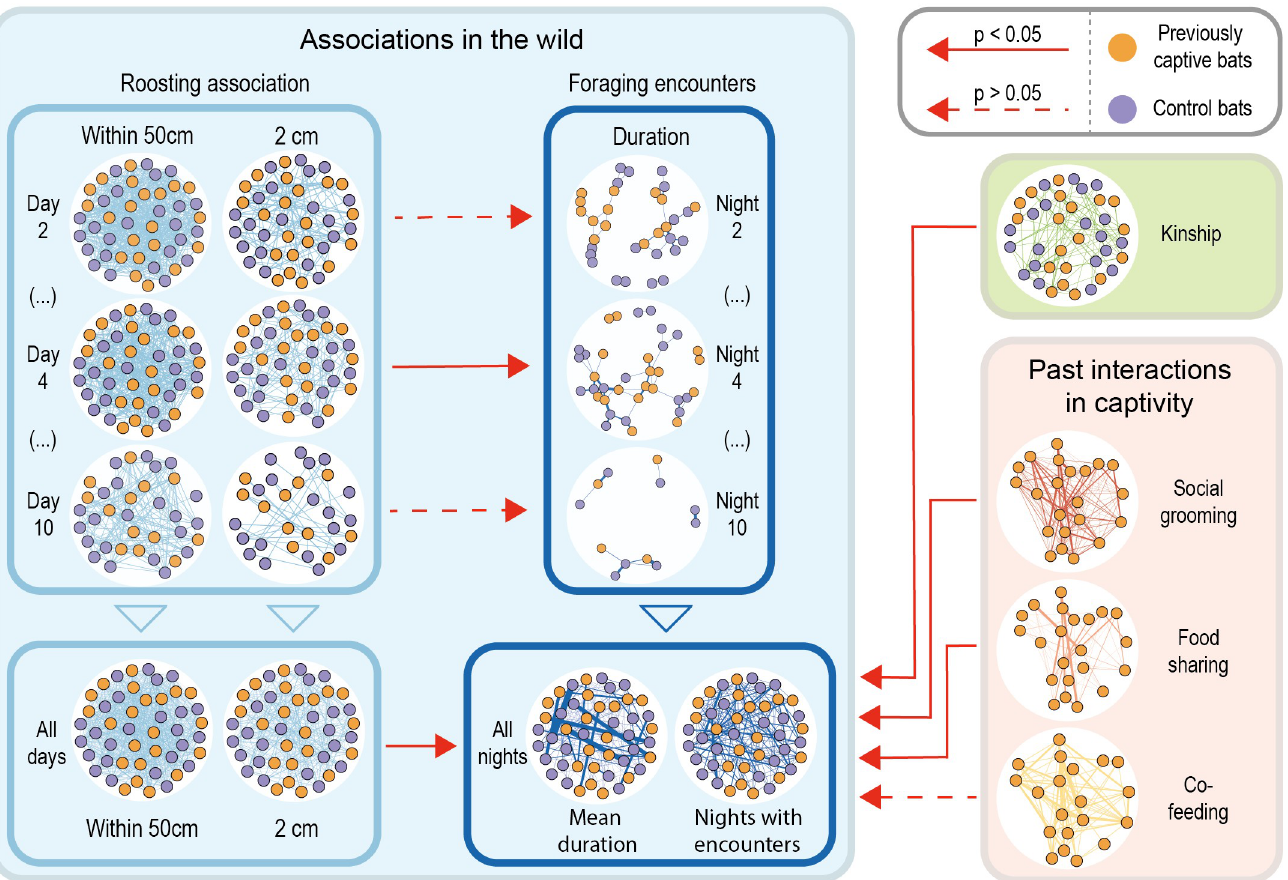
Fig 2. Network comparisons. Foraging encounter rates were predicted by roosting associations, kinship, and previous long-term rates of social grooming and food sharing in captivity. To facilitate visual comparisons, we applied the Fruchterman–Reingold algorithm to a fully connected unweighted network and used this layout to fix the spatial coordinates of nodes across networks (except for the sparse night-by-night foraging networks), we scaled edge strength in each network, and we removed nodes without edges. In the kinship network, only edges with kinship estimates > 0.24 are shown, and bats without kin in the group are not plotted. In the paired night–day networks of association in the wild, we only detected a clear correlation between day and night networks on day 4 (Table A in S1 Text). Numerical values underlying this figure are available in S1